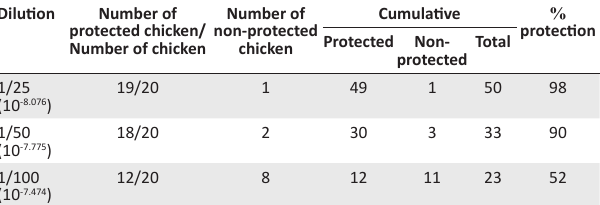
TABLE 6: Potency test of binary ethylenimine–inactivated Newcastle disease virus vaccine formulated in Freund’s incomplete adjuvant. Dilution Number of protected chicken/